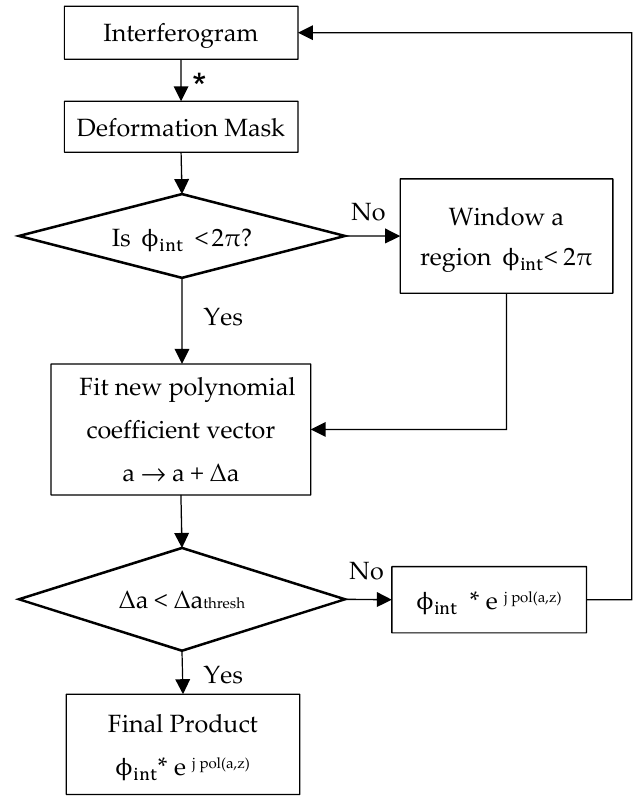
Figure 3. Static atmospheric phase removal: flowchart of the adopted iterative method for each tile.